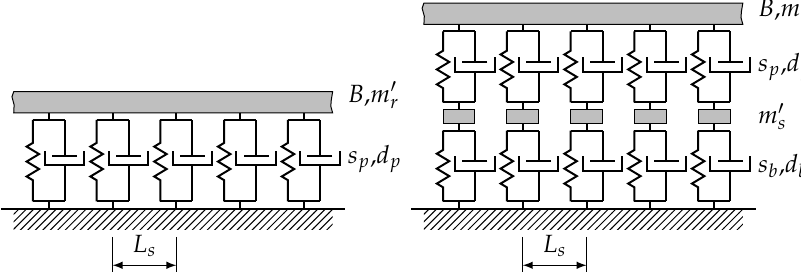
Figure 3. Models for single-layer and two-layer elastic foundation with discrete